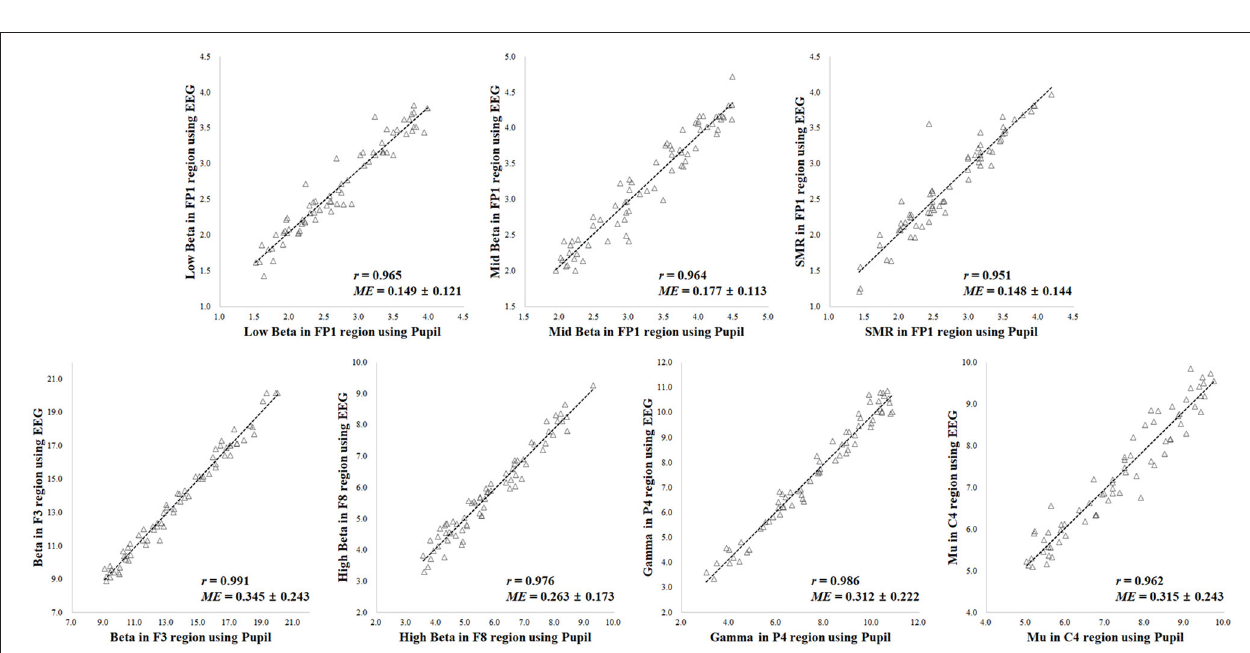
FIGURE 6 | Results of correlation analysis in variation of physiological state for coefficient ( r ) and mean error ( ME ) of electroencephalogram (EEG) spectral index between the pupil and EEG signals ( p < 0.001 [ n = 70]).